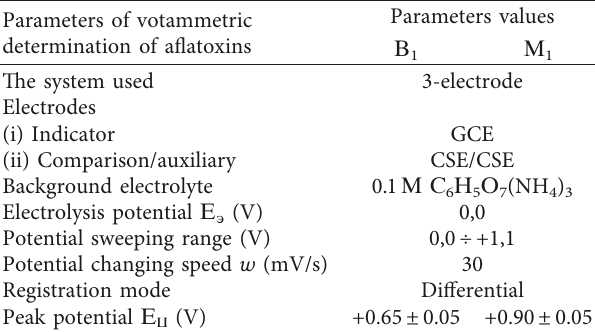
Table 1: Working conditions of the simultaneous voltammetric determination of aflatoxins C 1 and N 1 .